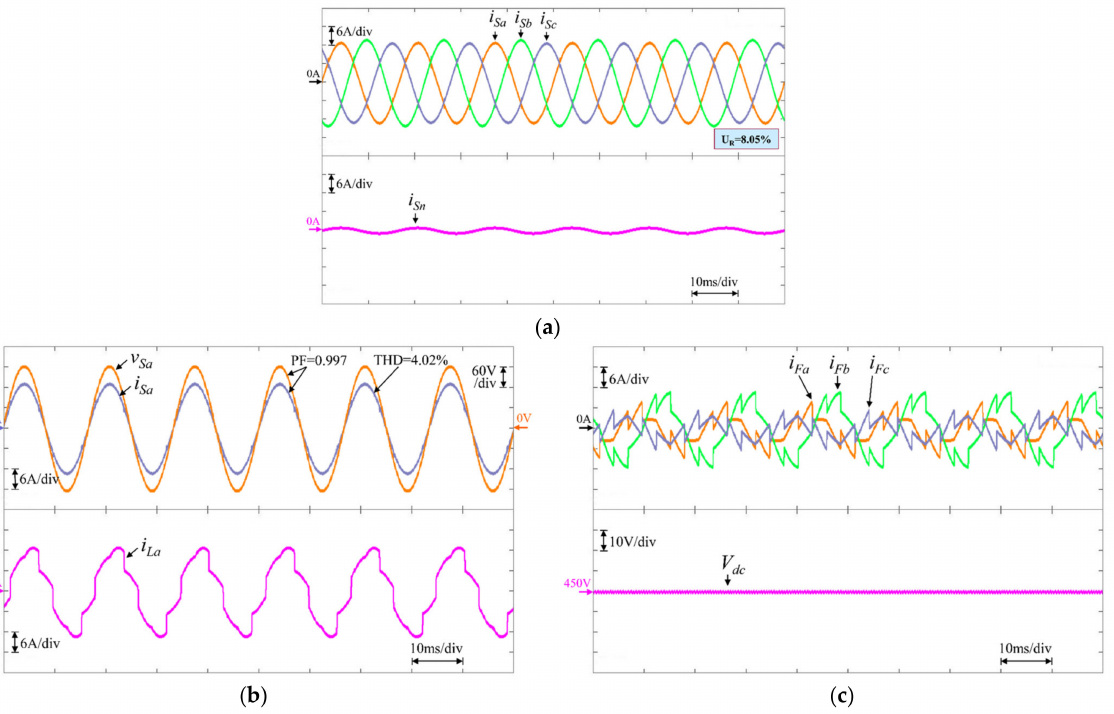
Figure 7. Experimental results using FNN-controlled DSTATCOM at RL2. ( a ) Response of grid currents and neural current; ( b ) Response of phase- a grid voltage, phase- a grid current, and phase- a load current; and ( c ) Response of compensation currents and DC-link voltage of